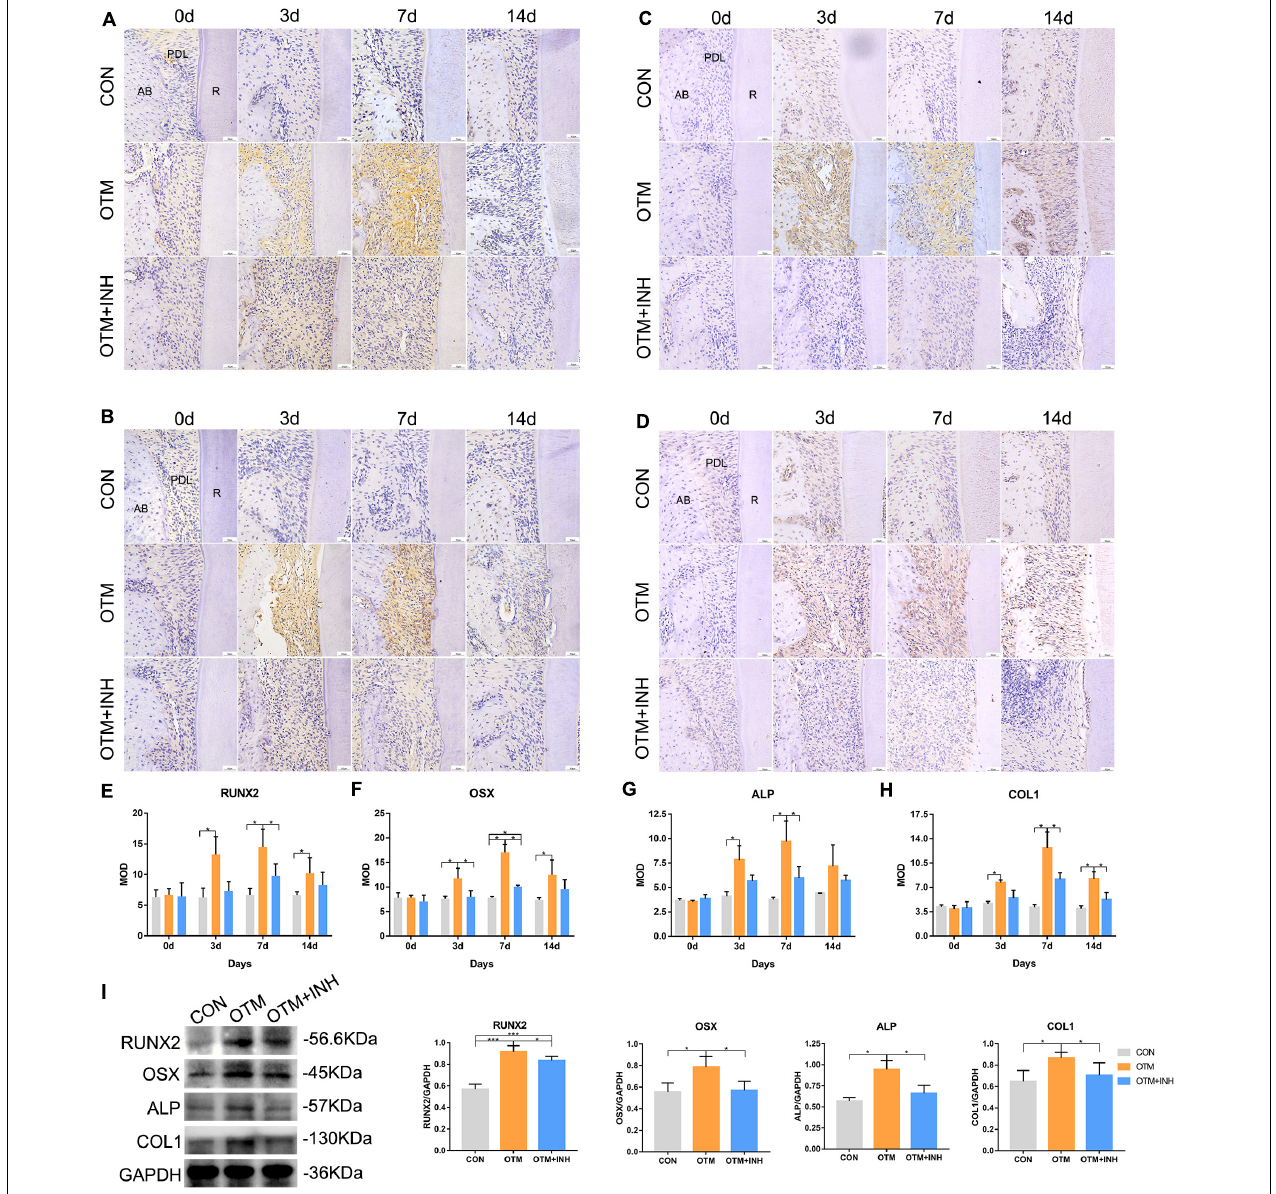
FIGURE 4 | Inhibition of Piezo1 channel suppressed expression of osteogenesis-related factors during OTM on the tension side. Immunohistochemical staining of RUNX2 (A) , OSX (B) , ALP (C) , and COL1 (D) of PDL on the tension side of the distobuccal roots and the means of the integrated optical density (IOD) of RUNX2 (E) , OSX (F) , ALP (G) , and COL1 (H) . The expression of RUNX2, OSX, ALP, and COL1 in the OTM group increased significantly on days 3, 7, and 14 compared with that of the CON group, while it was significantly reduced by GsMTx4 on day 3 and day 7 for OSX, day 7 for RUNX2 and ALP, and day 7 and day 14 for COL1. (I) Western blot analyses were carried out to detect the protein levels of RUNX2, OSX, ALP, and COL1 on day 7 of OTM. GsMTx4 significantly reduced the protein expression of RUNX2, OSX, ALP, and COL1 on day 7 in the OTM + INH group. Data are presented as the mean ± SD. * p < 0.05, *** p < 0.001. Scale bar = 50 µ m. RUNX2, Runt-related transcription factor 2; OSX, Osterix; ALP, alkaline phosphatase; COL1, collagen type 1; AB, alveolar bone; R, root.